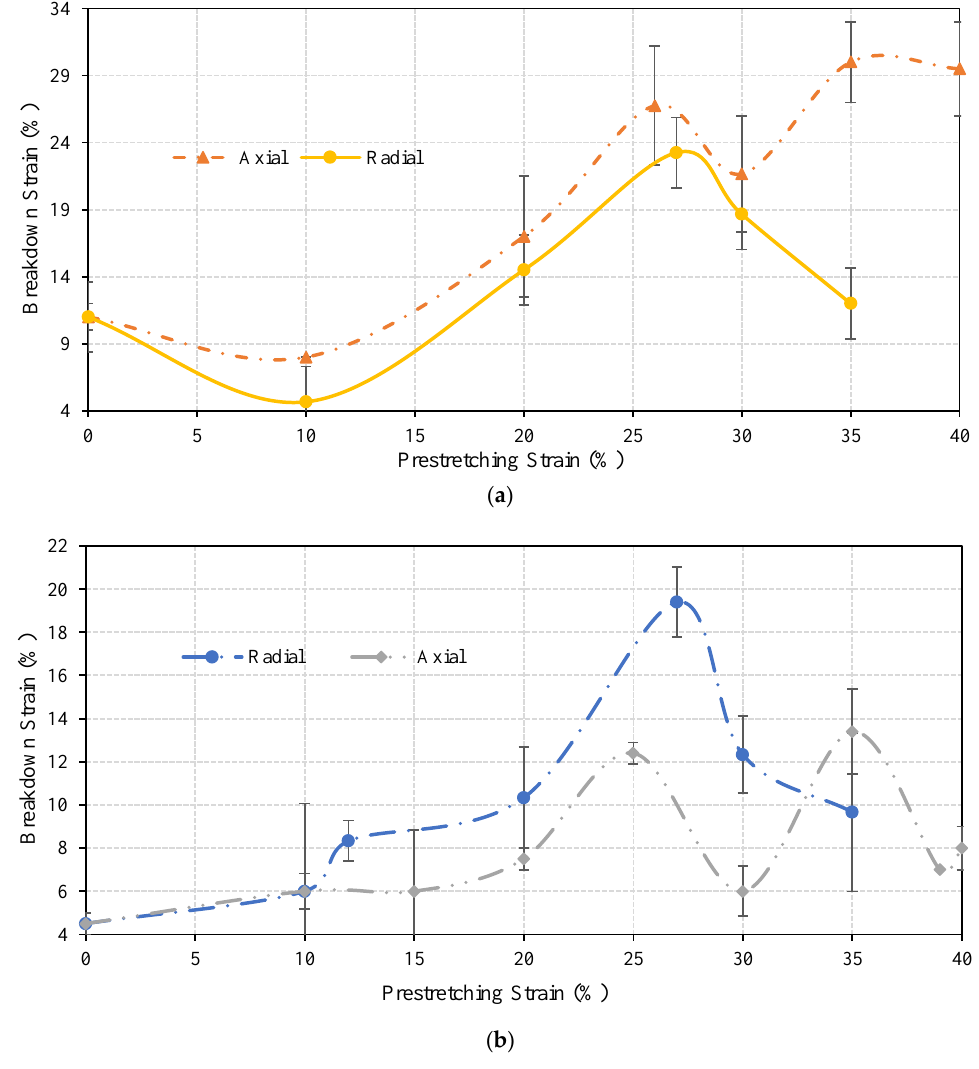
Figure 6. Average breakdown strains of conductive straight lines which were axially and radially pre-stretched with various values and examined under: ( a ) axial load, and ( b ) radial load.